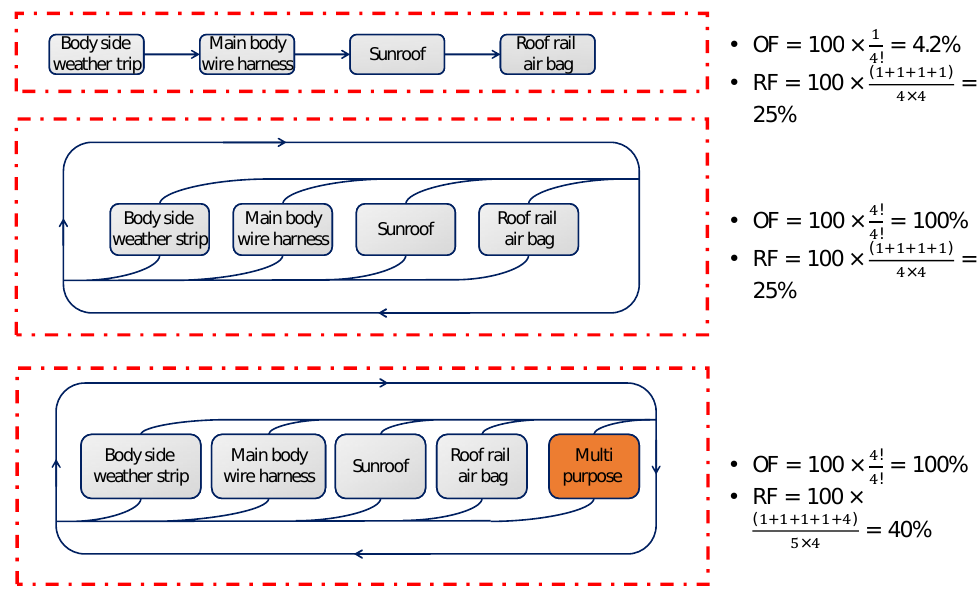
Figure 7. Different flexibility levels by different layouts:( Top ) In-line layout. ( Middle ) Matrix layout with each workstation capable of one dedicated operation. ( Bottom ) Matrix layout with one universal workstation capable of all four operations.